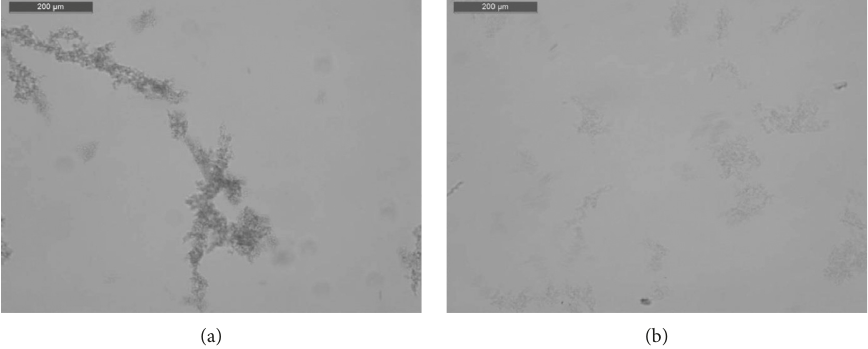
Figure 16: Hydrogels for CMC/CS 32: (a) after the hydrogel formation and (b) after 24hours of hydrogel formation.